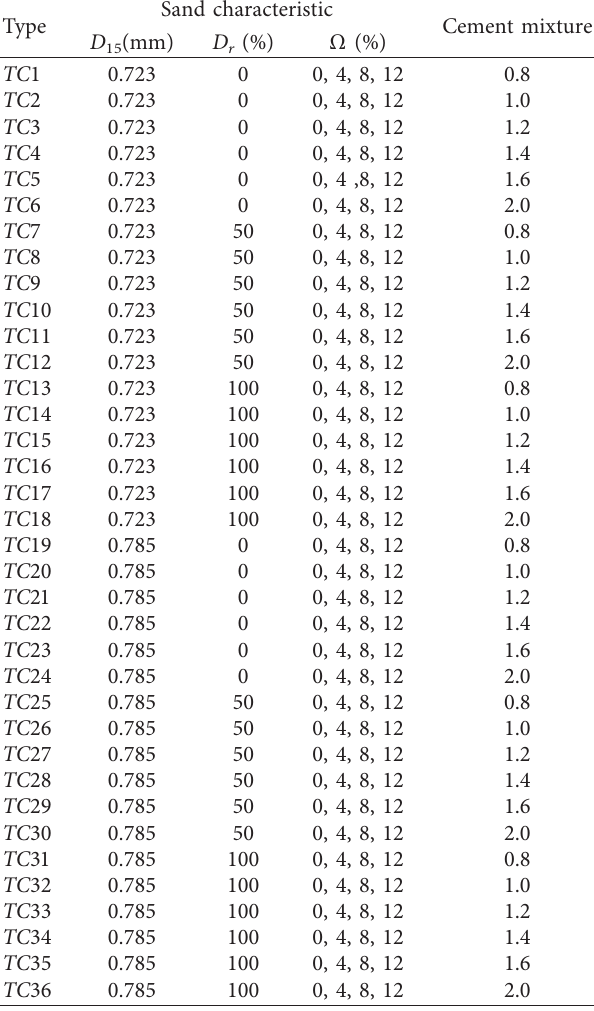
Table 6: The test plan for sand layer groutability with varying clay content.